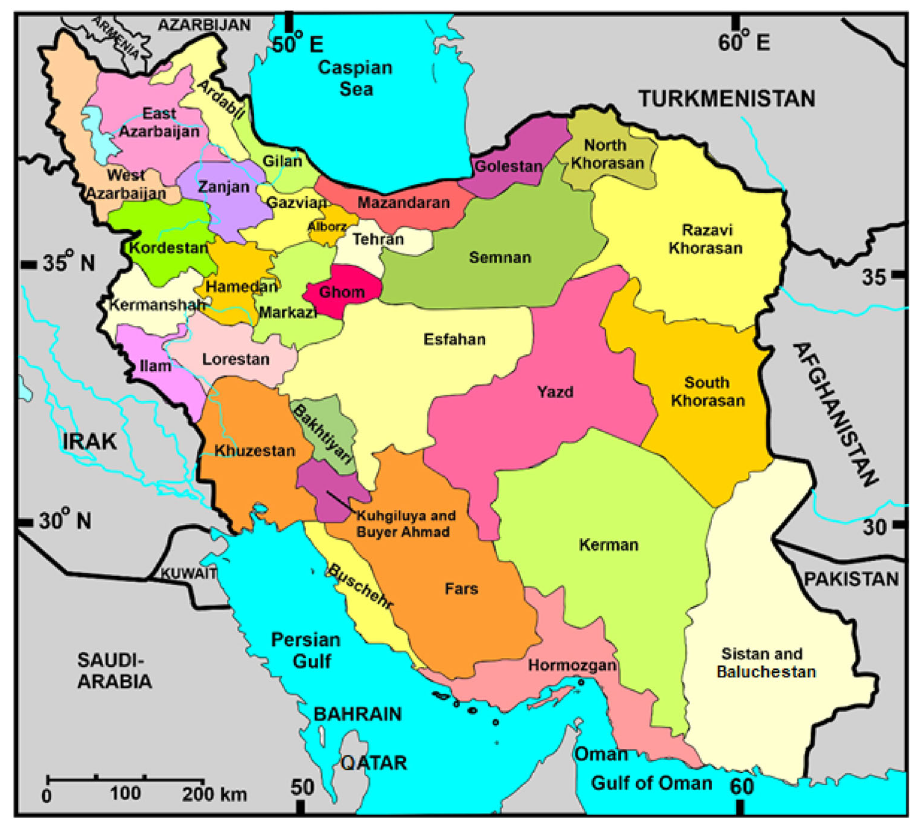
Fig. 1 Map of Iran showing the provinces. By size and population, Iran is ranked 17th and 18th in the world. Approximately three-fourths of Iran ’ s population resides in urban areas, mostly in water-rich regions of northwestern, western, and northern Iran. Out of 31 provinces, Kerman and Sistan and Baluchestan are the driest, while Gilan and Mazandaran are the wettest. Khuzestan and Ardebil have the highest and lowest temperatures,